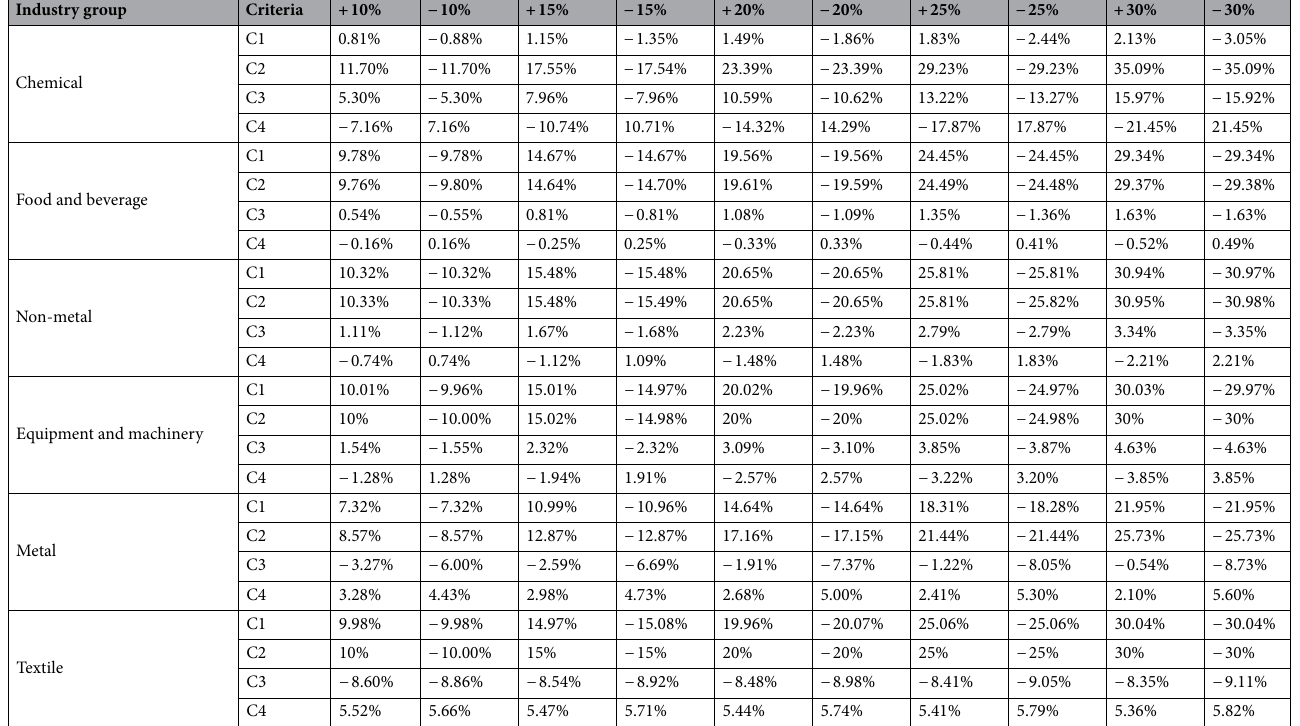
Table 9. Results of sensitivity analysis of the criteria by changing water allocations. C1, C2, C3, and C4 denote profit index, employment index, return of surface water, and groundwater sustainability index,